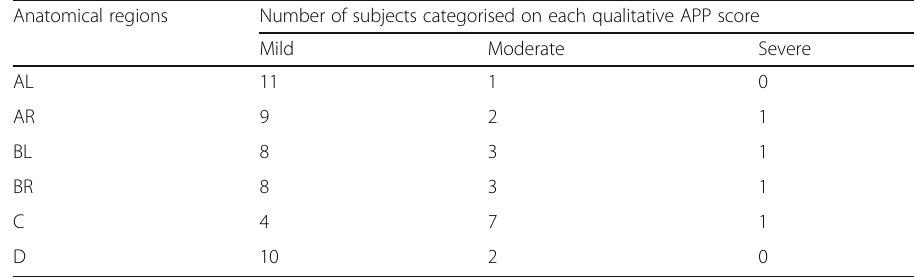
Table 6 Amyloid precursor protein (APP) staining qualitative scores by tissue region after a severe head injury model Anatomical regions Number of subjects categorised on each qualitative APP score Mild Moderate